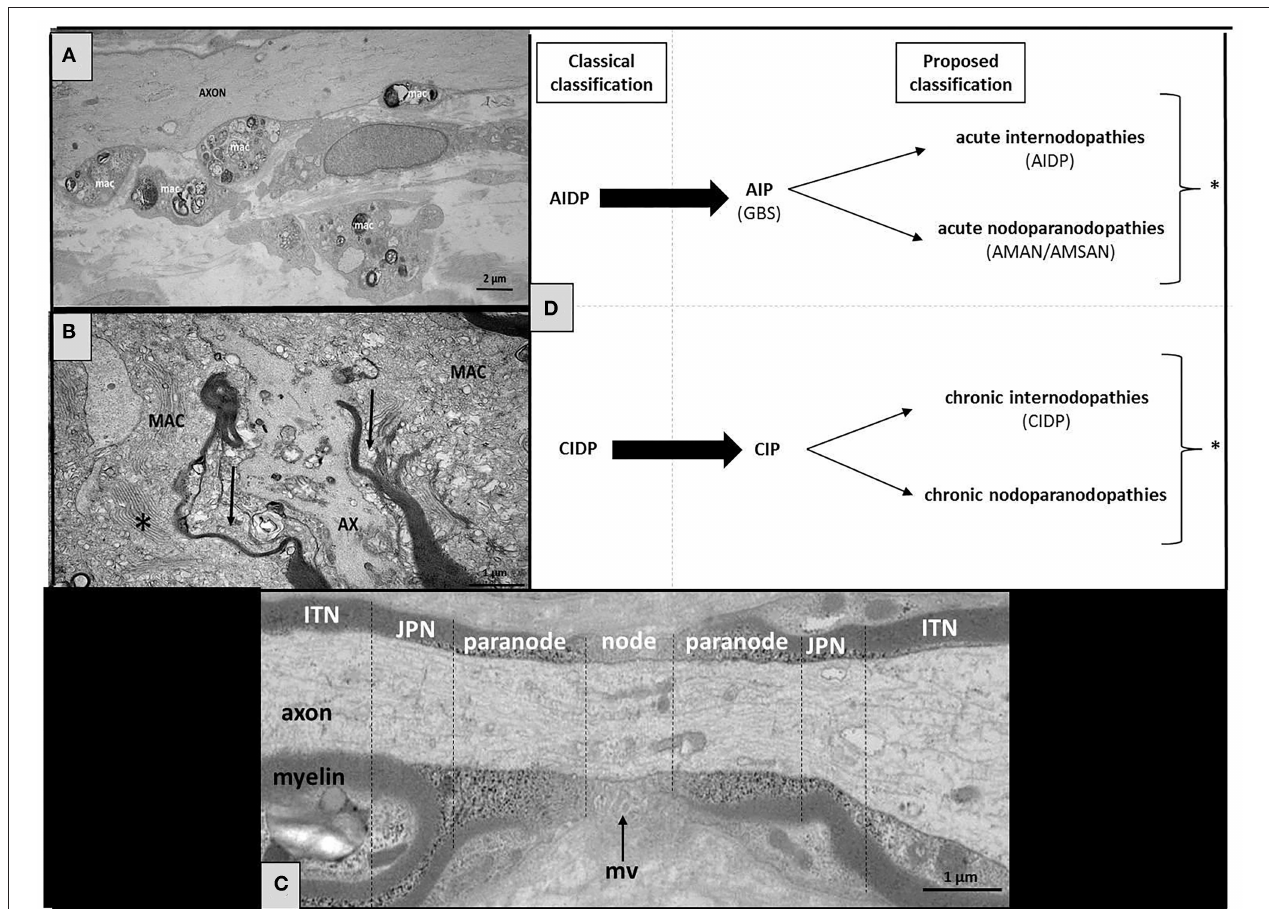
FIGURE 1 | Structure of the normal and pathological node of Ranvier, with a proposed classification of the nodoparanodopathies. (A) Electron microscopy micrograph of longitudinal section of the sural nerve biopsy from a CIDP patient. We observe the presence of large diameter axons (AXON) completely devoid of myelin at the level of an internode. Several macrophages overloaded with myelin debris (mac) are seen in close contact to axons. (B) Electron microscopy micrograph of longitudinal sections of the sural nerve biopsy from a patient with nodo-paranodopathy. We observe macrophages containing vesicular-like myelin debris (*) are dissociating the paranodes (arrows). (C) Longitudinal section of a normal human peripheral nerve at level of the node of Ranvier area (JPN, juxta-paranode; ITN, internode; mv, microvilli). (D) In our proposed classification, we indicate the probabilities of where the target antigens/sites of pathology are likely to be (* some patients may present both types of lesions: internodopathy and